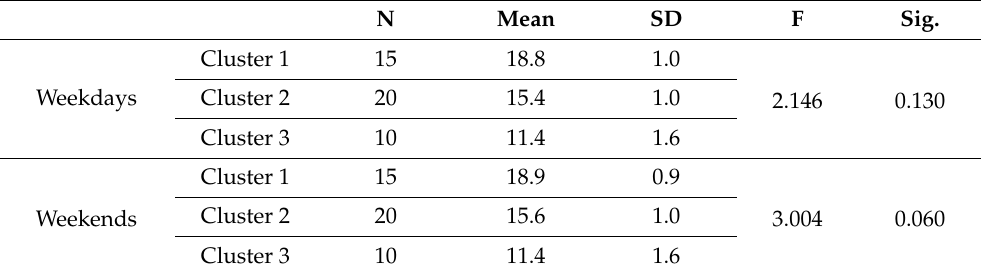
Table 10. Descriptive analysis of the mean temperature of each cluster based on the mean temperature of each dwelling and Levene’s test results in winter. N Mean SD F